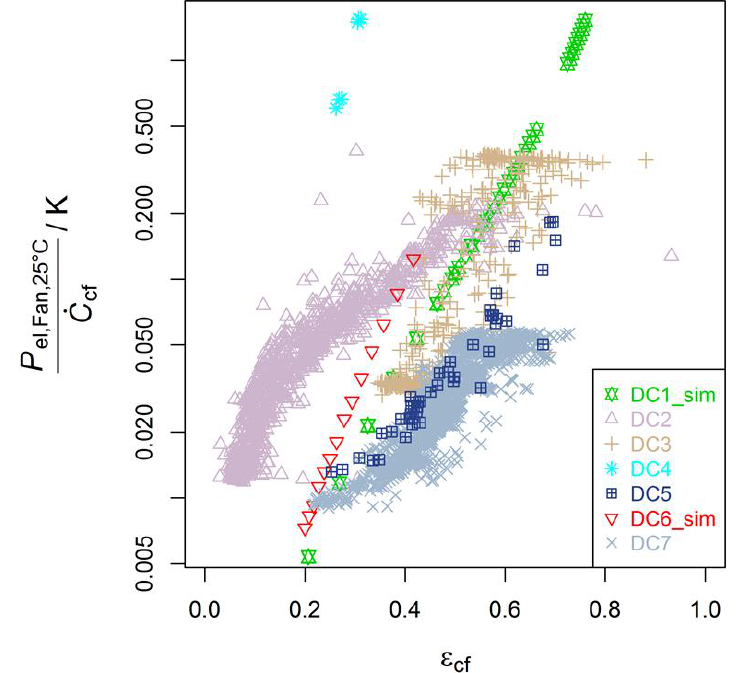
Figure 6. Electric power for fans at 25 °C ( 𝑃 capacity flow rate versus cooling effectiveness ( ϵ coolers (in boundary